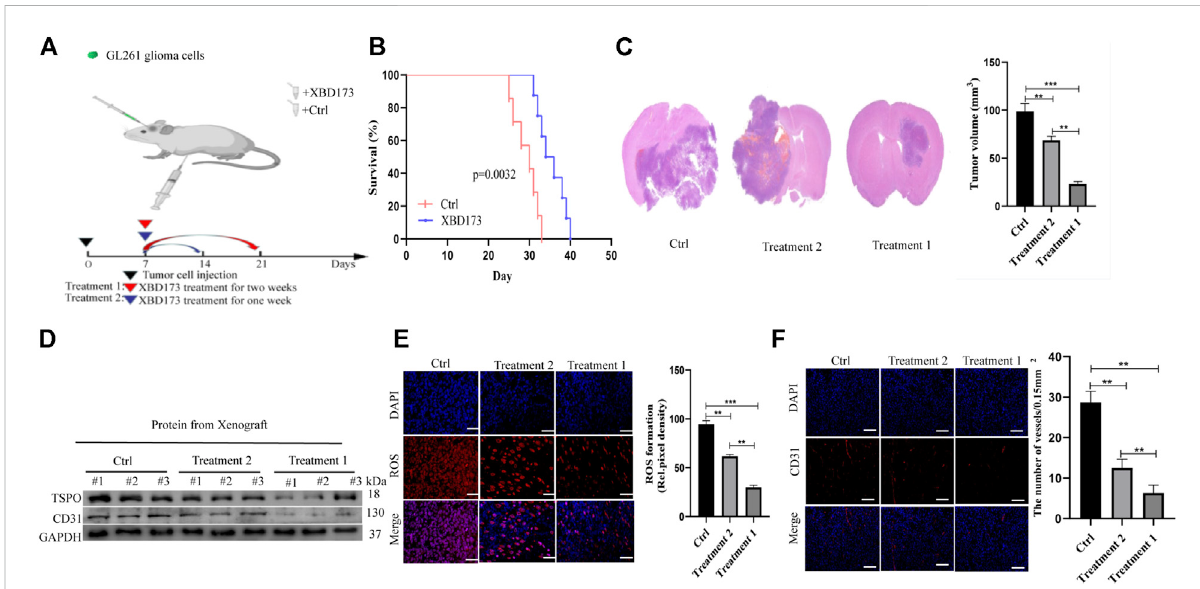
FIGURE 4 TSPO promotes GBM pathogenesis and angiogenesis in vivo . (A) Schematic diagram of targeted therapy in vivo . Xenograft models were established by intracranialinjectionof (1× 10 6 cells),whichweredirectly inoculatedinto thelateral ventricle of nudemice. TheXBD173or DMSOwastreatedeverydayafter 1 week following the xenotransplantation, and treatment was repeated one or 2 weeks; (B) Kaplan – Meier survival curves of tumor-bearing mice received the indicated treatments (n = 7); (C) H&E staining of the brains isolated from mice received the indicated treatments. Scare bar: 100 μ m; (D) Western blot analysisofthelevelsoftheangiogenesis-associatedprotein(CD31)andTSPOingliomatissues; (E) RepresentativeimagesofROSproduction.Scalebars,50 μ m; (F) Representativeimmunohistochemical analysisof CD31 expressioninintracranial Xenograft tissue. Scalebars, 50 μ m. Three independentexperimentswere performed. The data are presented as the means ± SEM. All images represented as the mean ± SD of three independent experiments; * p < 0.5; ** p < 0.01; *** p <